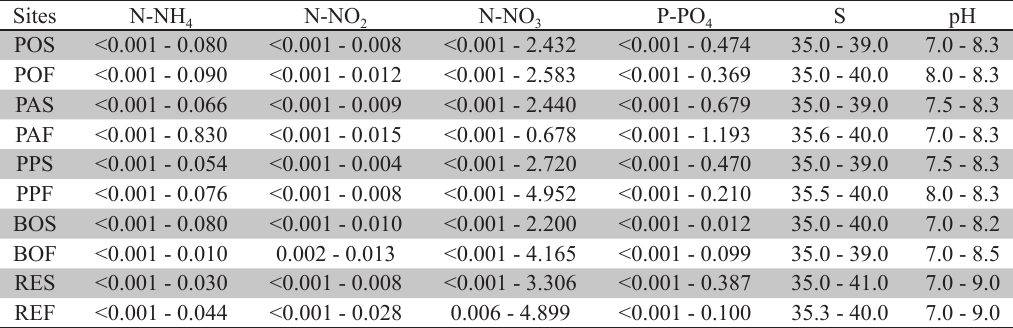
Range in concentrations of nutrients (µM), salinity and pH in the studied sites including all samplings. N-NH = Ammonia; N-NO 4